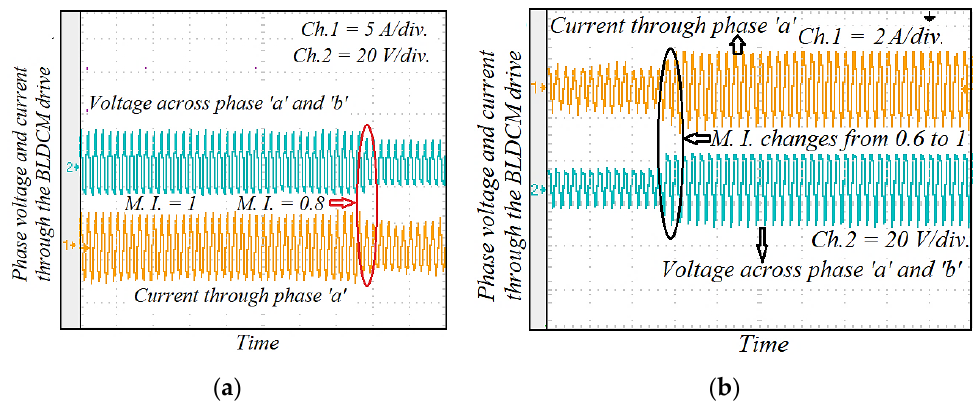
Figure 21. Experimental results of phase current and output voltage across the VSI unit during the dynamic conditions: ( a ) MI changes from 1.0 to 0.8; and ( b ) MI increases from 0.6 to